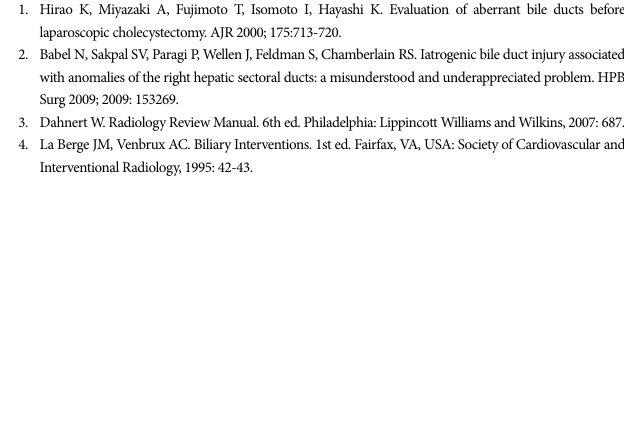
Fig. 4. Anatomical variations of the right posterior sectoral bile